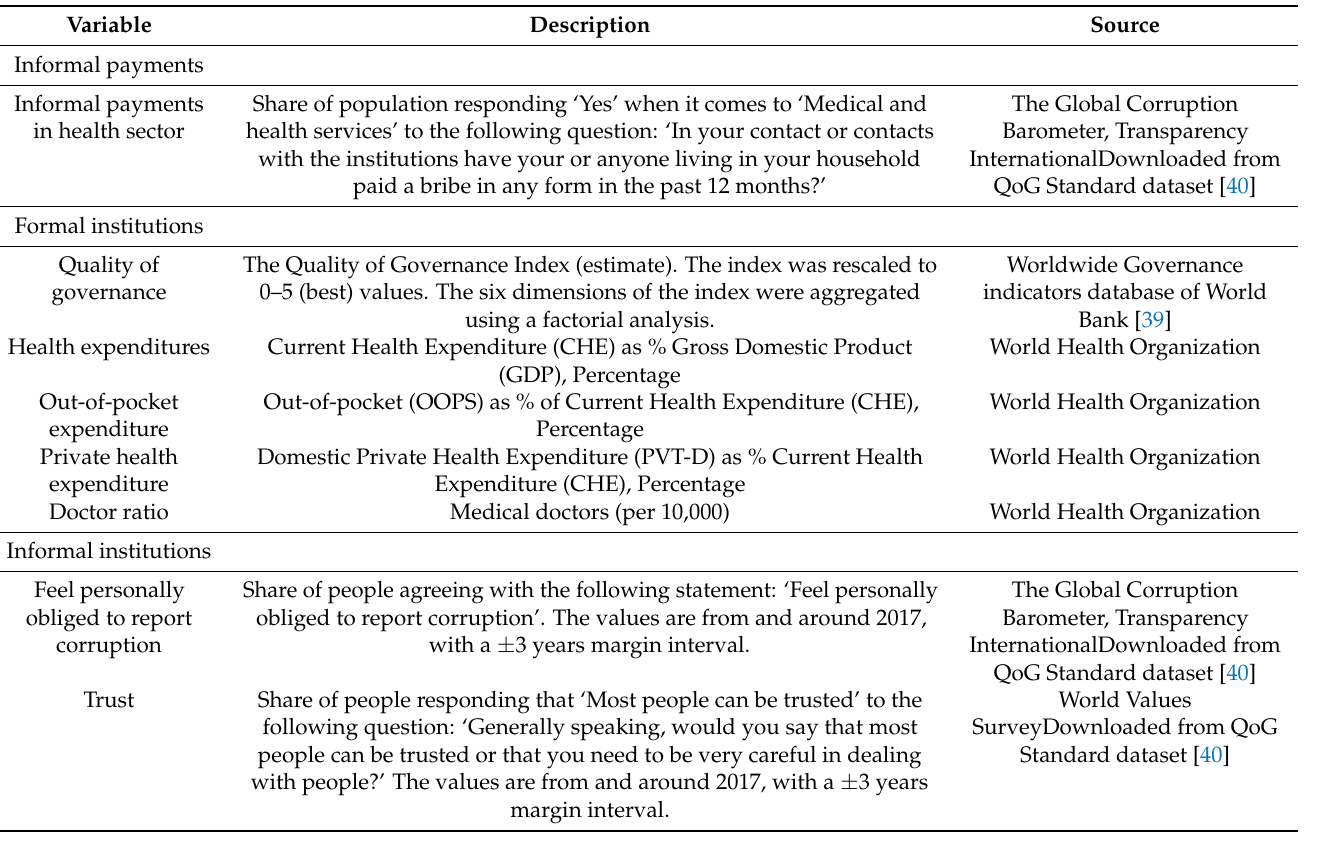
Table A1. Data description and